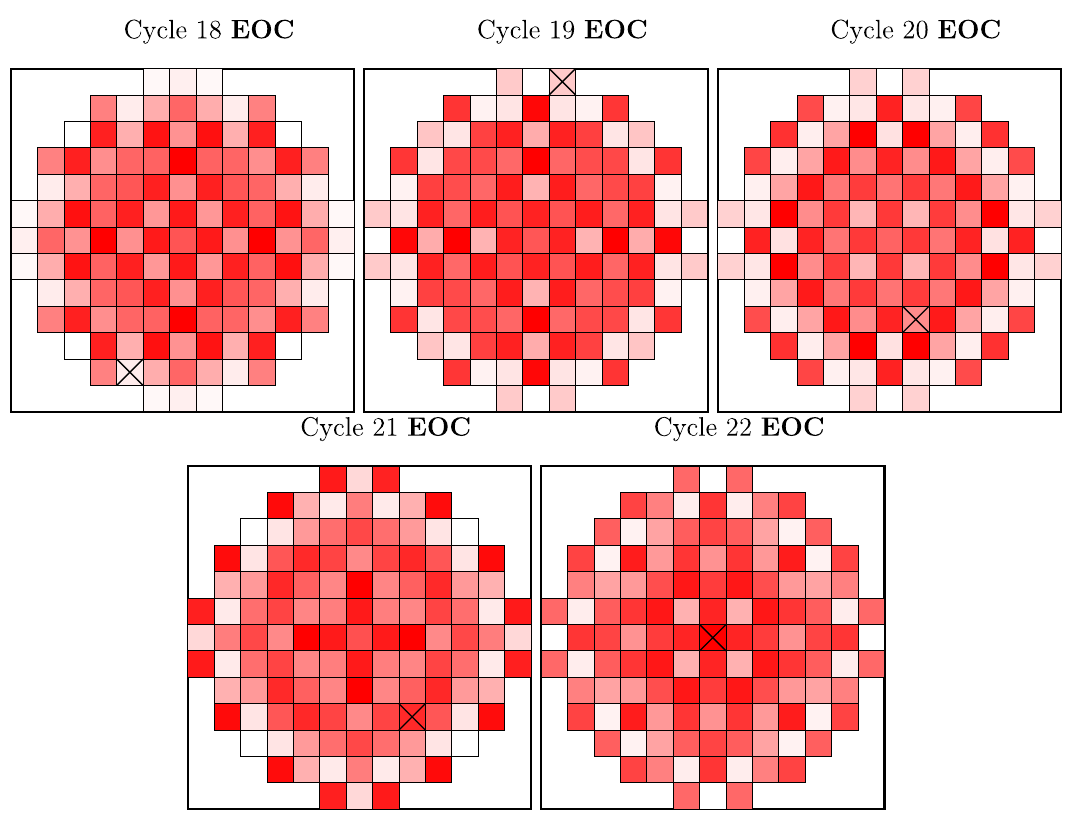
Fig. 2. Locations of the assemblies M109 (cycles 18–22) containing the BM1 and BM3 samples. The positions of M109 are indicated by a cross. The colors are proportional to the assembly burnup obtained from SIMULATE–3 at the end of each cycle (EOC): white for low burnup and dark red for high burnup